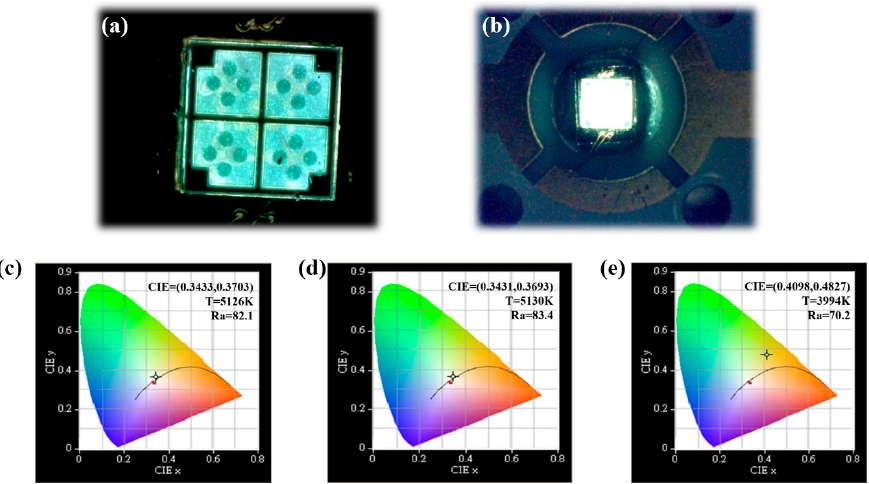
Figure 5. ( a ) The images of the FC package QD/QW cool white LED driven at 5 mA; ( b ) The images of the light outputs from QD/QW white LEDs were taken as the current increased to 50 mA. The color temperatures and color coordinates of color rendering of white QD/QW LEDs at different bias currents of ( c ) 350 mA; ( d ) 500 mA; and ( e ) 700 mA .